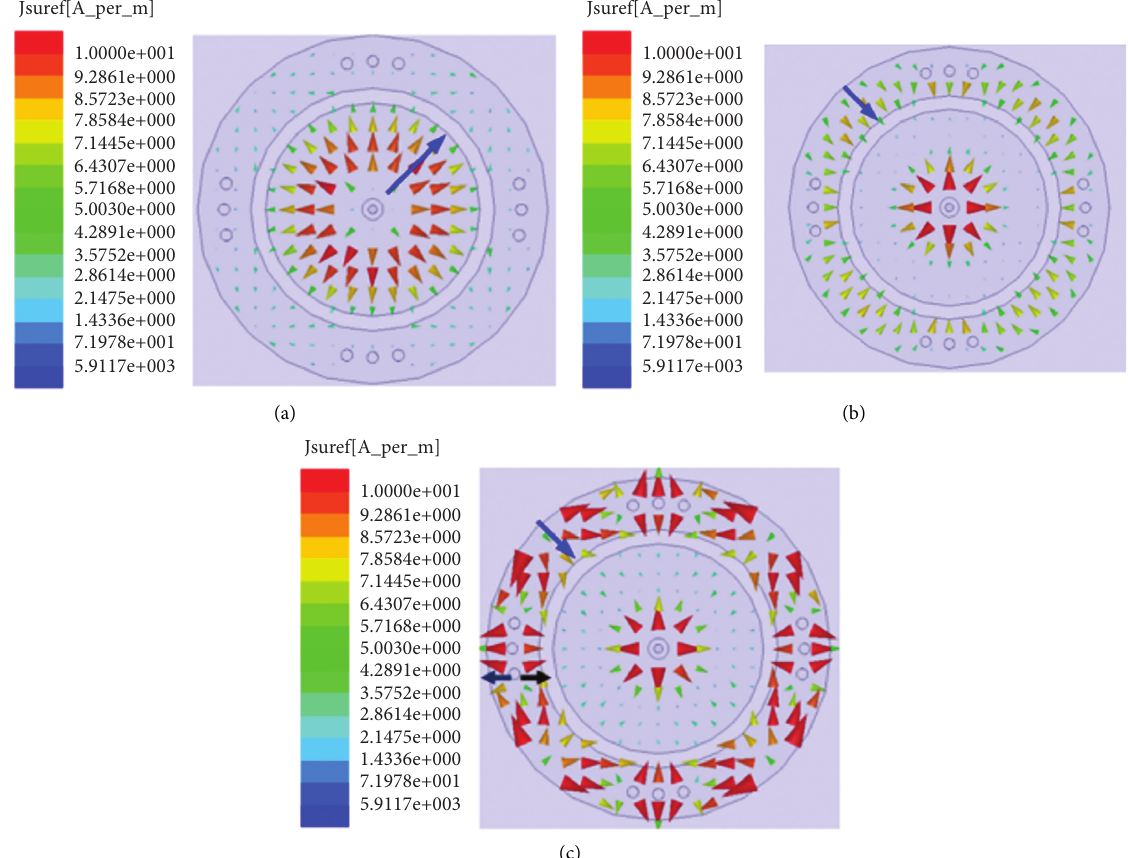
Figure 3: The current distribution on the patch. (a) 5.4GHz, (b) 6.2GHz, and (c)